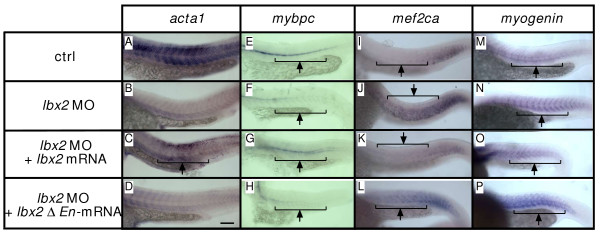
The Engrailed domain of Lbx2 is required for myofilament gene expression. A-H: Expression of acta1 (A-D) and mybpc1 (E-H). Embryos express acta1at 24 hpf (A: 93% with normal expression, n = 15). Injection of lbx2-MO results in decreased acta1 expression (B: 20% with normal expression, n = 20), whereas acta1 expression partially recovers in embryos injected with lbx2-MO + lbx2 mRNA (C: 42% with normal expression, n = 50). In contrast, embryos injected with lbx2-MO + lbx Δ En mRNA fail to express acta1 (D: 14% with normal expression, n = 37). mybpc1 (E: 94%, n = 18; F: 43%, n = 23; G: 81%, n = 31; H: 42%, n = 38). I-P: Expression of mef2ca (I-L) and myogenin (M-P). Embryos express mef2ca at 24 hpf (I: n = 11). Injection of lbx2-MO results in increased mef2ca expression (J: 72% with increased expression, n = 11), whereas mef2ca expression partially recovers in embryos injected with lbx2-MO + lbx2 mRNA (K: 21% with increased expression, n = 19). In contrast, embryos injected with lbx2-MO + lbx Δ En mRNA fail to express mef2ca (L: 61% with increased expression, n = 21). myogenin (M: n = 7, N: 78% with increased expression, n = 9, O: 23%, n = 13, P: 67%, n = 14). (A-P) Whole mounts, lateral views, rostral toward the left, dorsal toward the top. Scale bar: 100 μm.